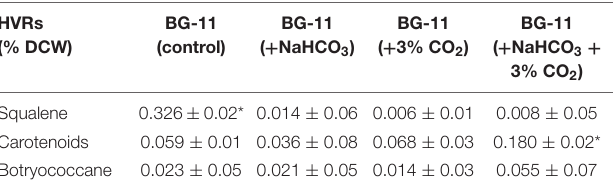
TABLE 3 | The high value-added renewable profile of Botryococcus braunii on the 10 th day supplemented with different carbon sources. HVRs BG-11 (% DCW)